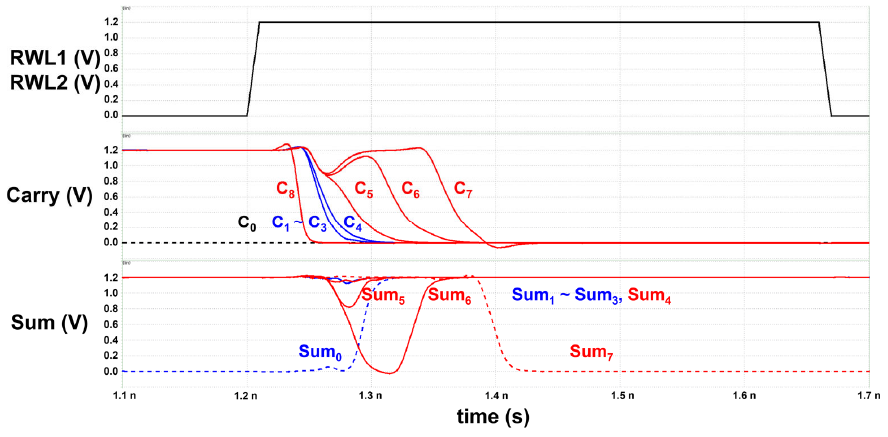
Figure 10. Timing graph of the proposed 8 ‐ bit IMC approximate adder.